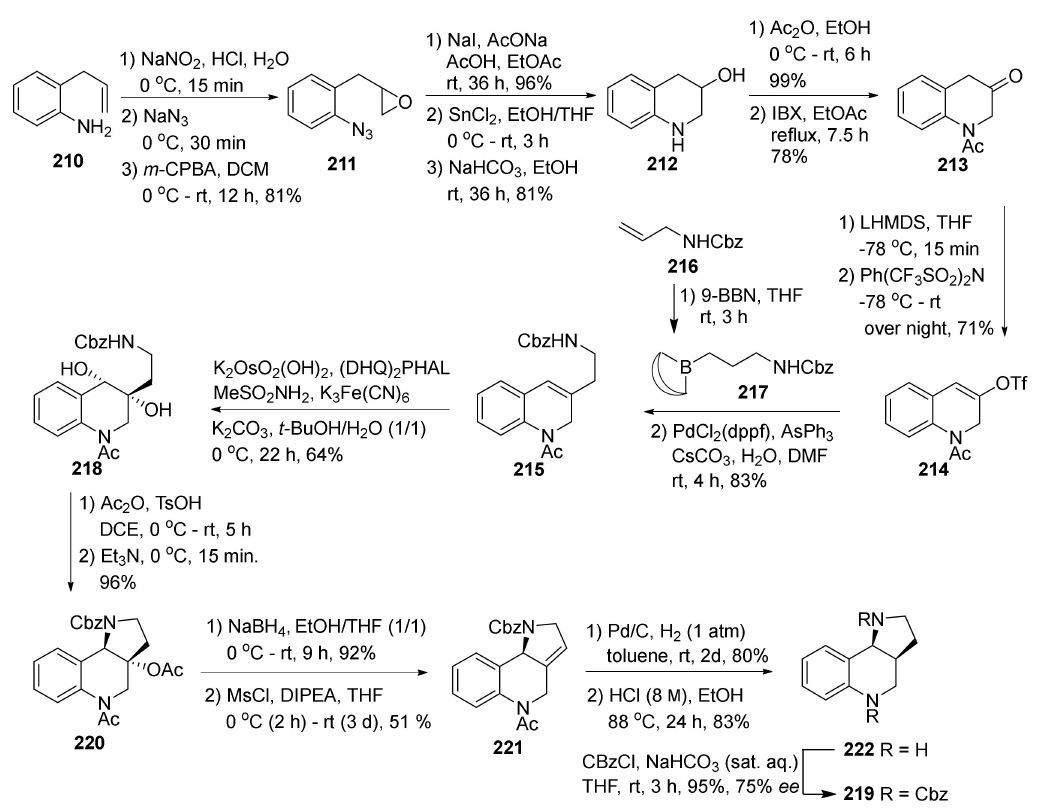
Scheme 35. Scaffold synthesis by Lindbäck and